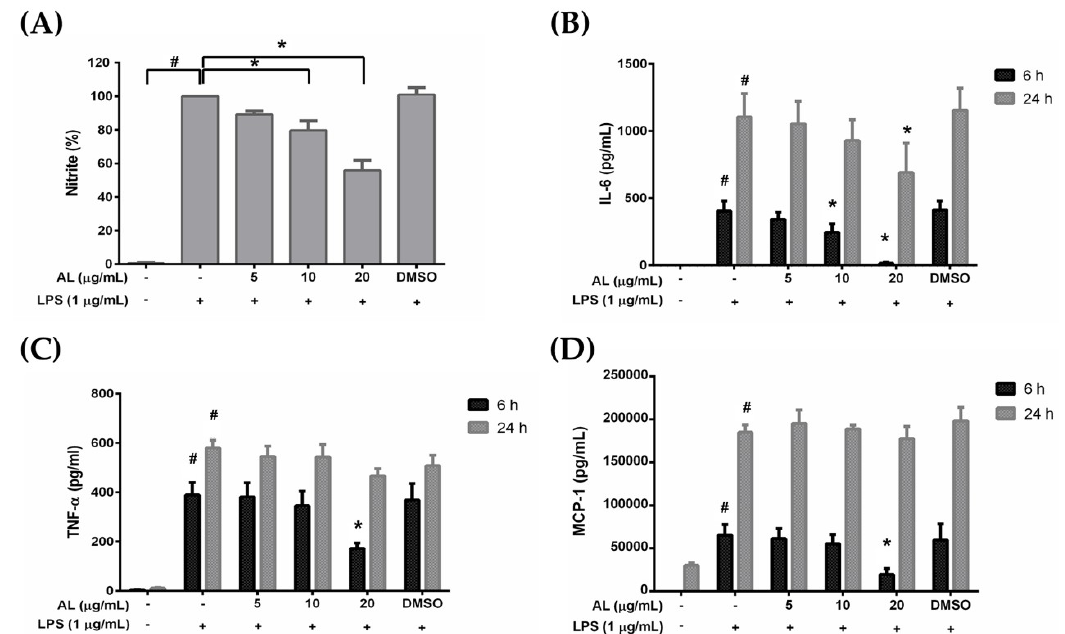
Figure 3. ( A ) The inhibitory e ff ect of AL extract on lipopolysaccharide (LPS)-induced nitric oxide (NO) production in the supernatants of RAW 264.7 cells treated with di ff erent concentrations of AL extract (5, 10, and 20 µ g / mL) for 24 h; ( B ) ELISA for the secreted level of IL-6 in the supernatants of cells treated with di ff erent concentrations of AL extract with the presence of LPS for 6 and 24 h; ( C ) ELISA for the secreted level of TNF- α in the supernatants of cells treated with di ff erent concentrations of AL extract with the presence of LPS for 6 and 24 h; ( D ) ELISA for the secreted level of MCP-1 in the supernatants of cells treated with di ff erent concentrations of AL extract with the presence of LPS for 6 and 24 h. Data are representatives of three replicates and shown as mean ± SD; # p < 0.05 (compared to the untreated control) or * p < 0.05 (compared to the LPS-treated group).